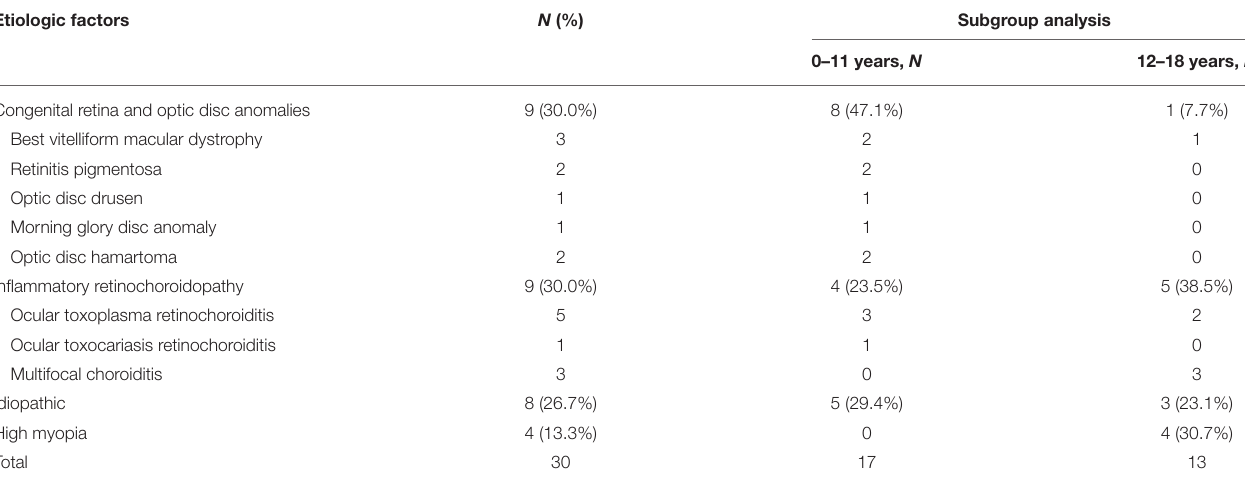
TABLE 3 | Distribution of etiology by age range for patients with choroidal neovascular membrane. Etiologic factors